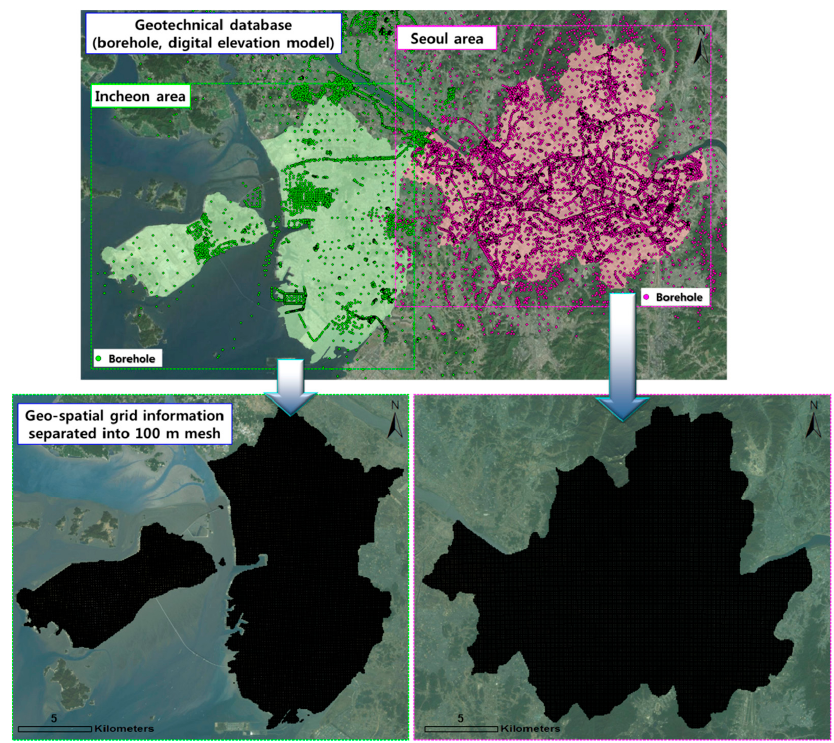
Figure 2. Geotechnical database (DB) and geo-spatial grid information at 100 m intervals for the Seoul and Incheon areas. Table 2. Spatial distribution of geotechnical layer thickness based on geo-spatial grid information in the Seoul and Incheon areas.